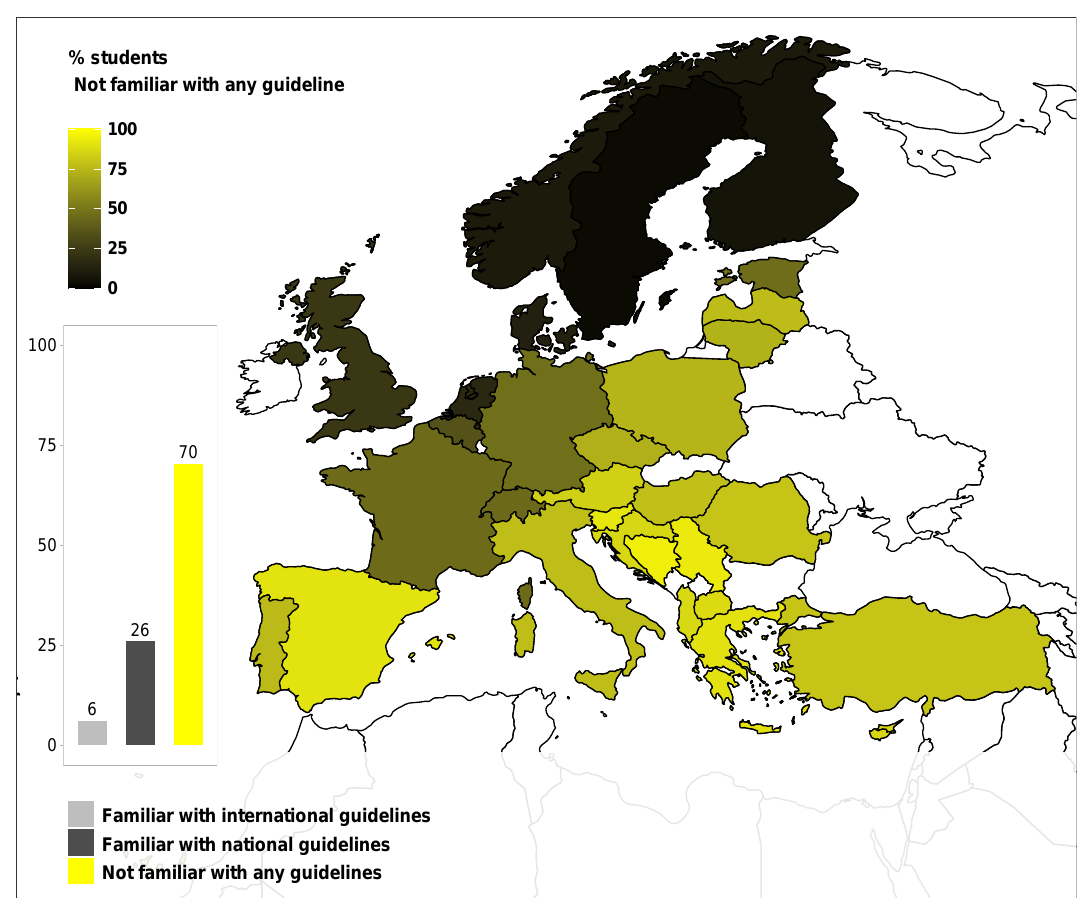
Figure 4. Percentage of final-year veterinary students that are not familiar with national or international guidelines for rational antimicrobial use, as reported in question 24 of the survey: “Are you familiar with any practice guidelines for rational antimicrobial use?”. The bar plot shows the percentage of students selecting each of the answers available (bottom legend). The map displays the percentage of students that selected the answer: “Not familiar with any guideline” (top-left legend). Bar plots may display added percentages above or below 100% due to rounding of the